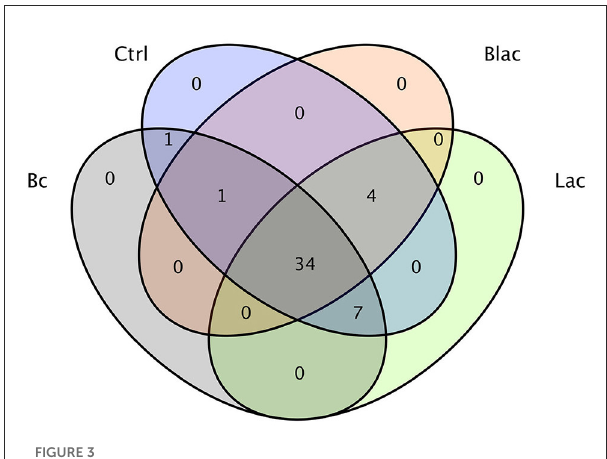
FIGURE3 Operational taxonomic unit (OTU) Venn diagram of silage microorganism.